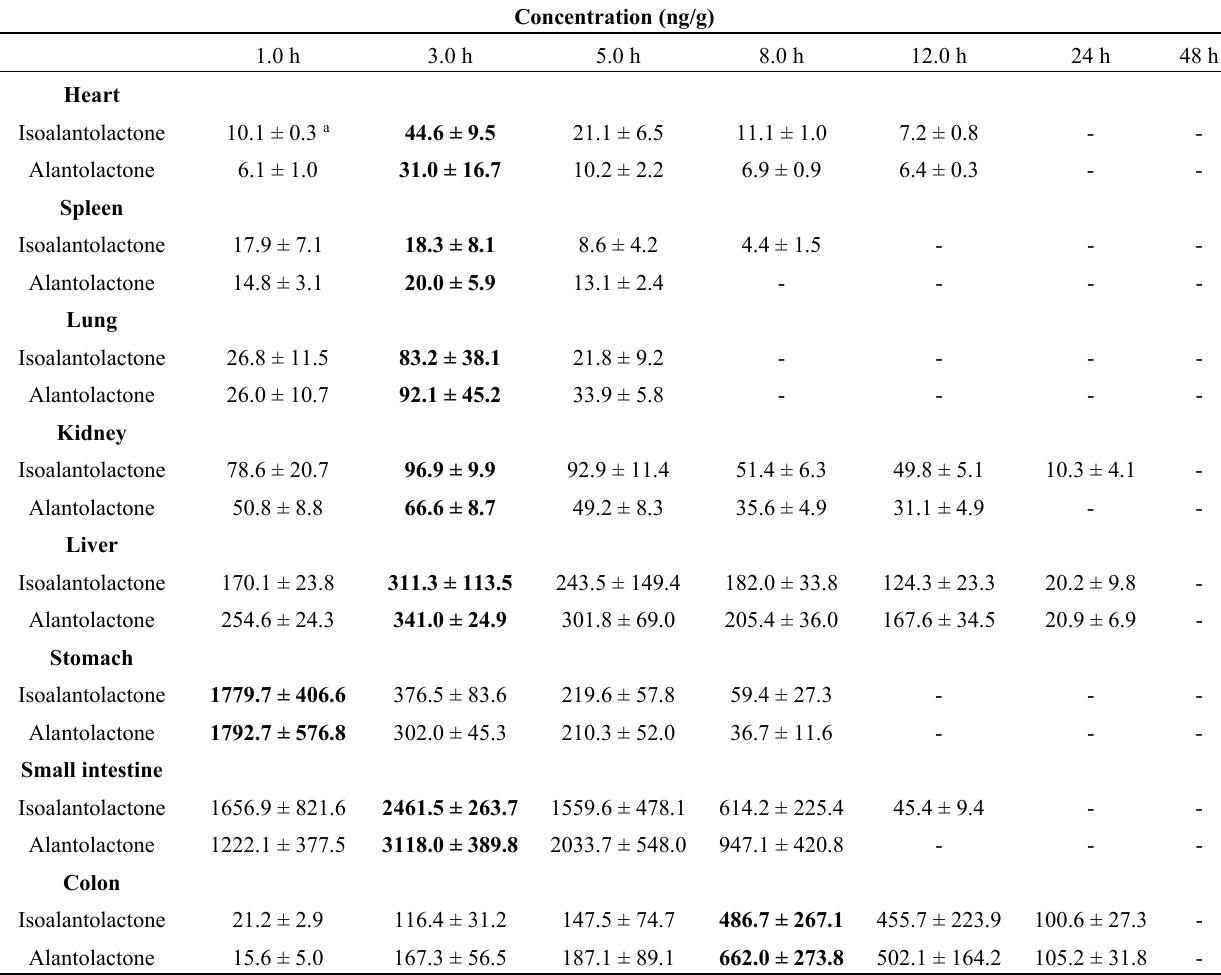
Figure 4. The AUC (0-48h) of isoalantolactone and alantolactone in tissues following oral administration at a single dose of 90 mg/kg Radix Inulae extract ( n = 6). Table 3. Isoalantolactone and alantolactone concentration (ng/g) 1–48 h after oral administration in rats ( n =